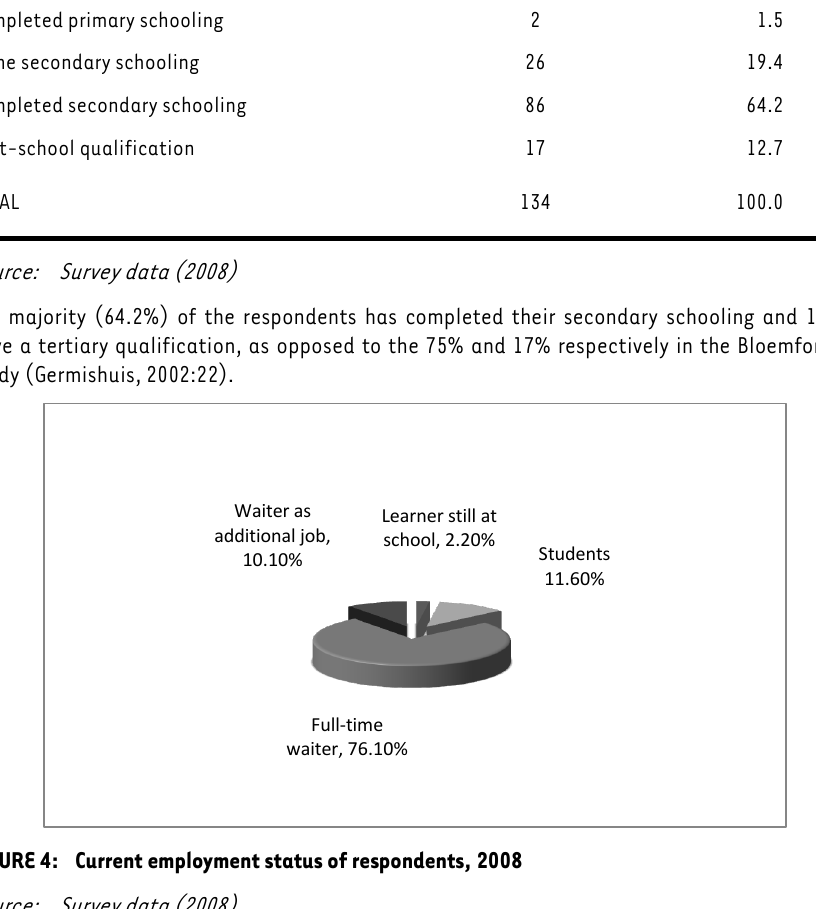
Frequency Valid %